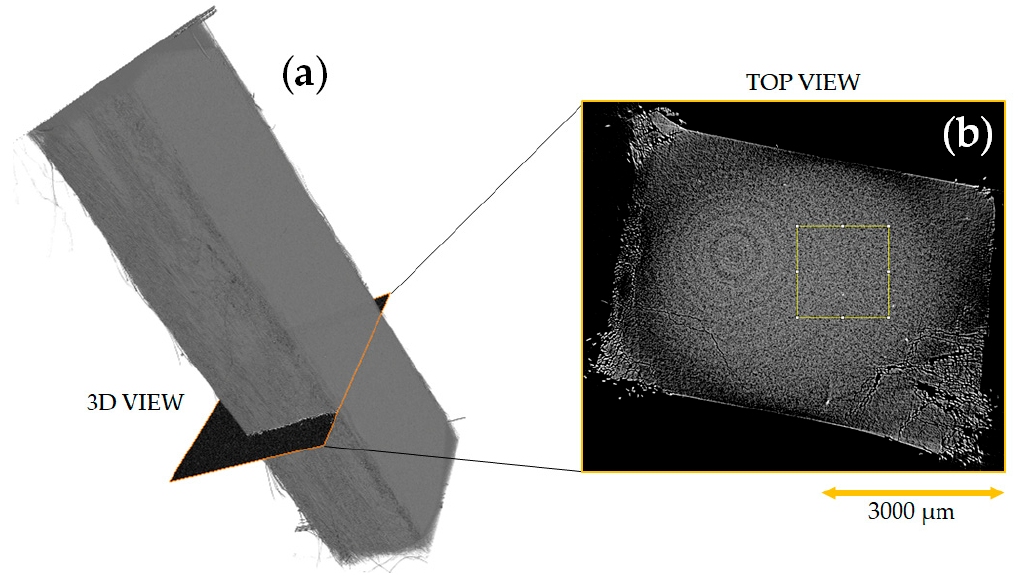
Figure 14. X-ray tomography ( a ) and cross-section ( b ) for SRC obtained at 165 and 25 MPa (Regime 1).